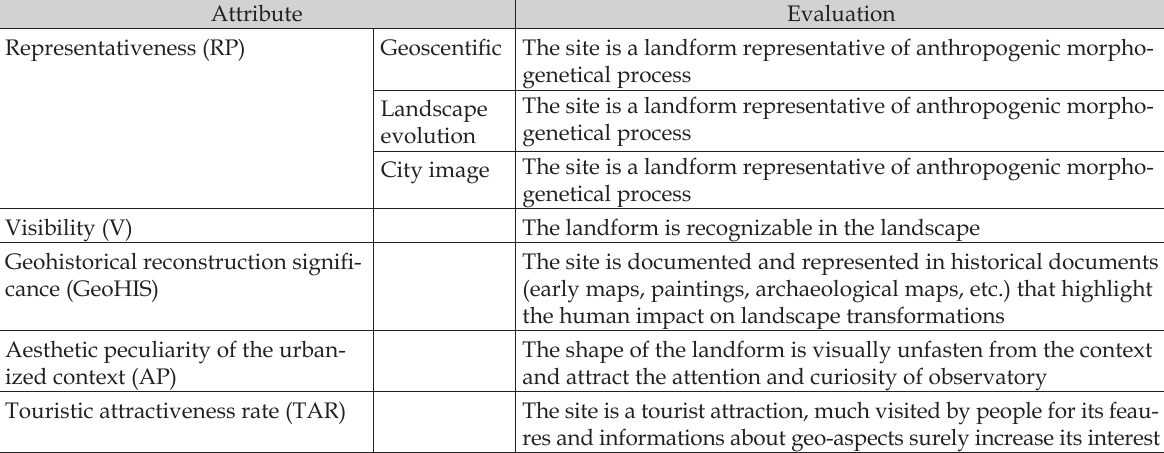
Table 1. list of proposed attributes for the urban geomorphoheritage